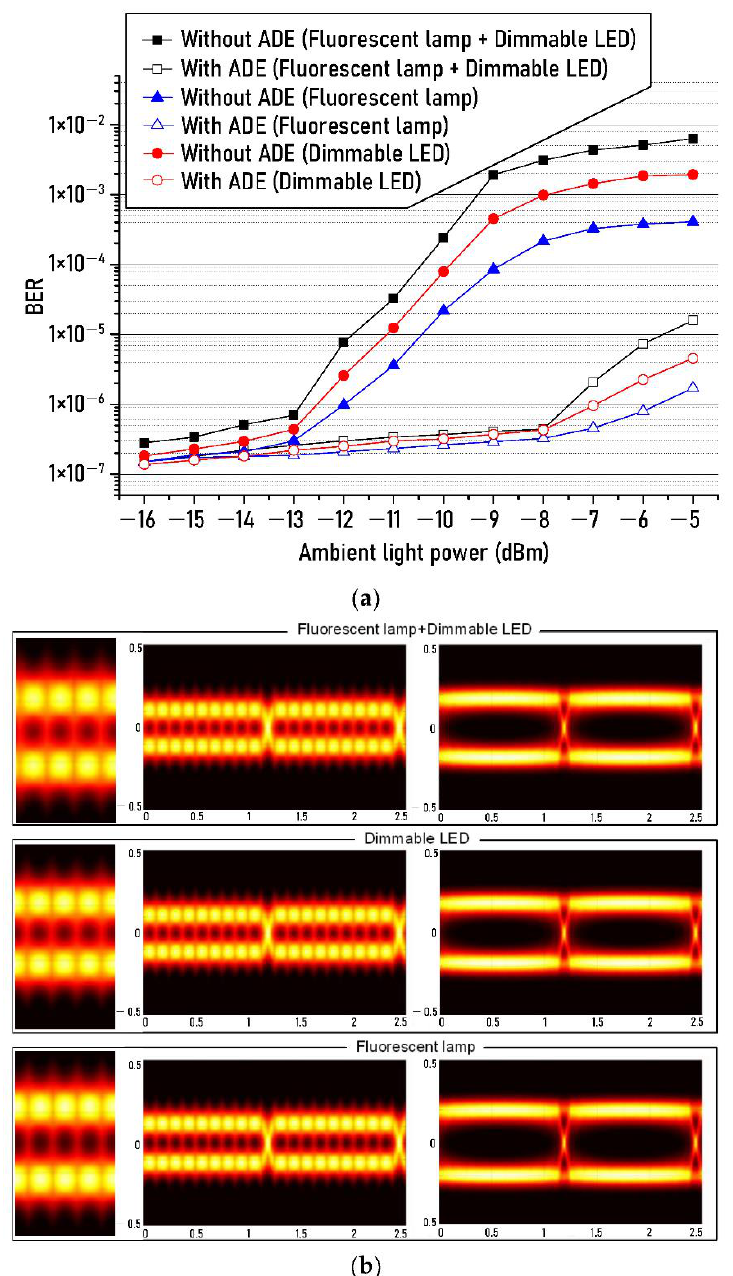
Figure 7. ( a ) BER changes of recovered NRZ − OOK signal as the optical power of ambient light increases from − 16 dBm to − 5 dBm, ( b ) eye diagrams at the ambient light power of − 5 dBm, which were measured for three kinds of cases. Insets on the far left: enlarged eye patterns of each case before using the proposed ADE.